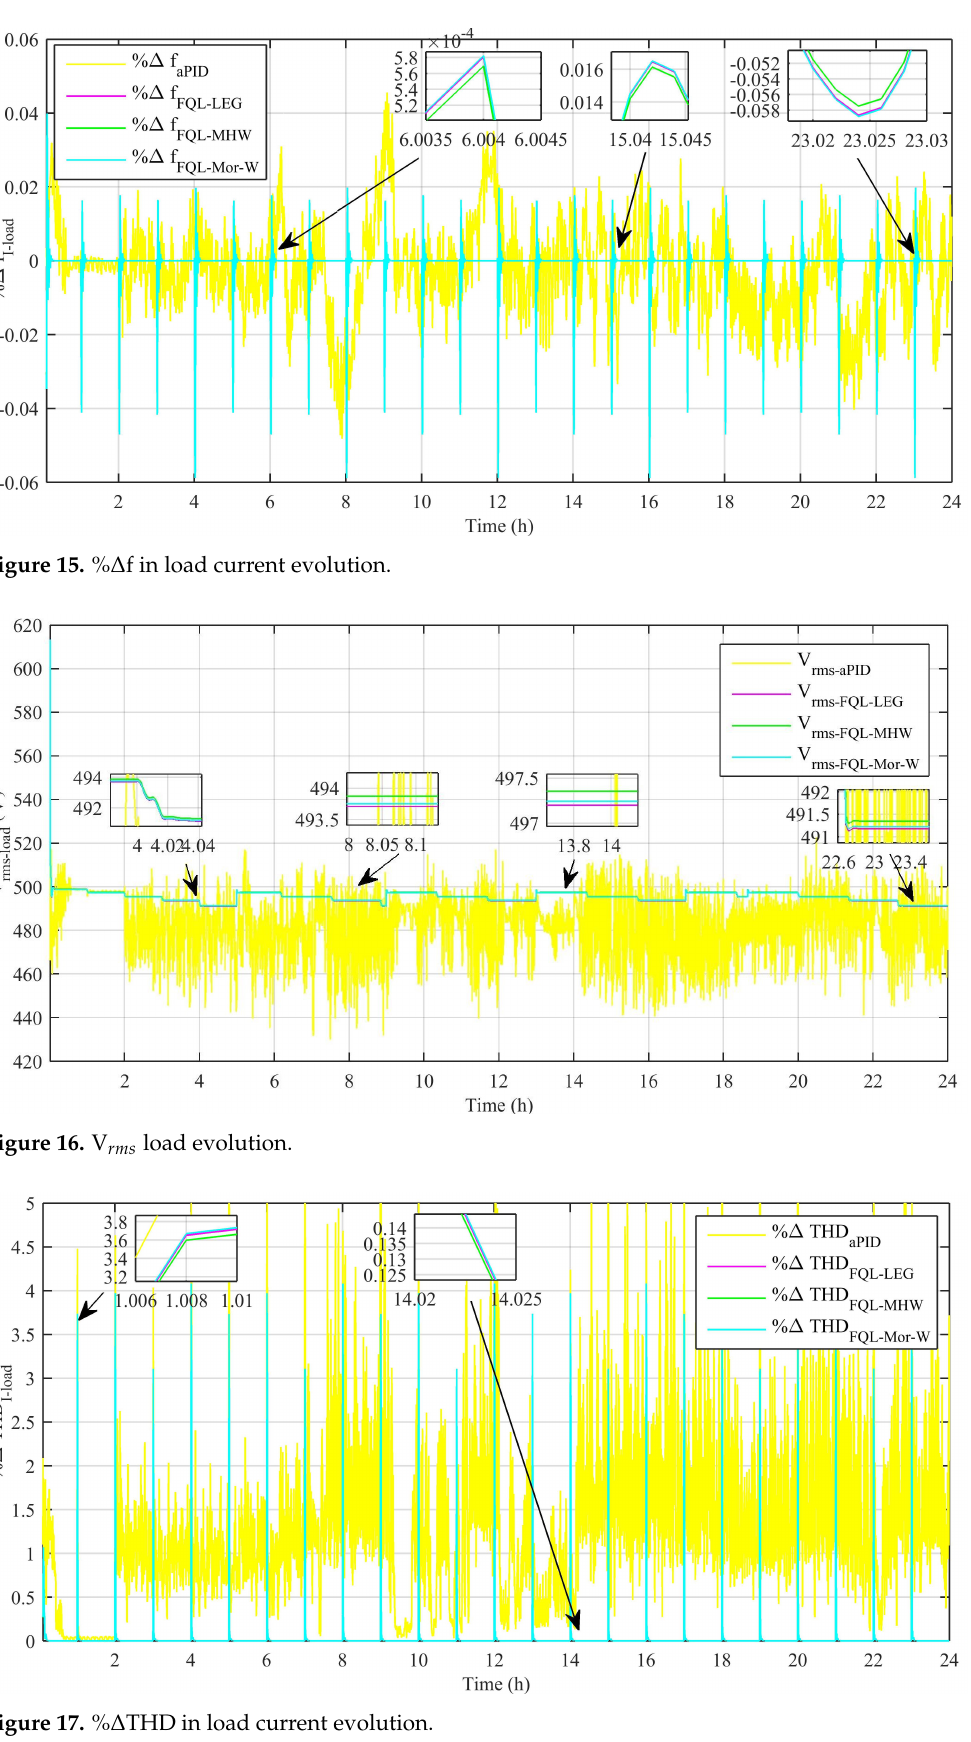
Figure 17. % ∆ THD in load current